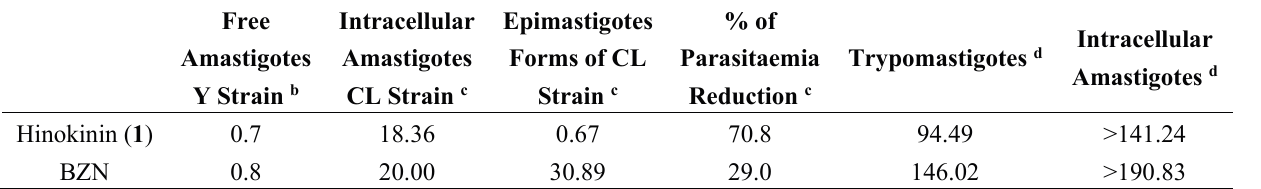
Table 3. In vitro anti-trypanosomal activity of hinokinin ( 1 ). a